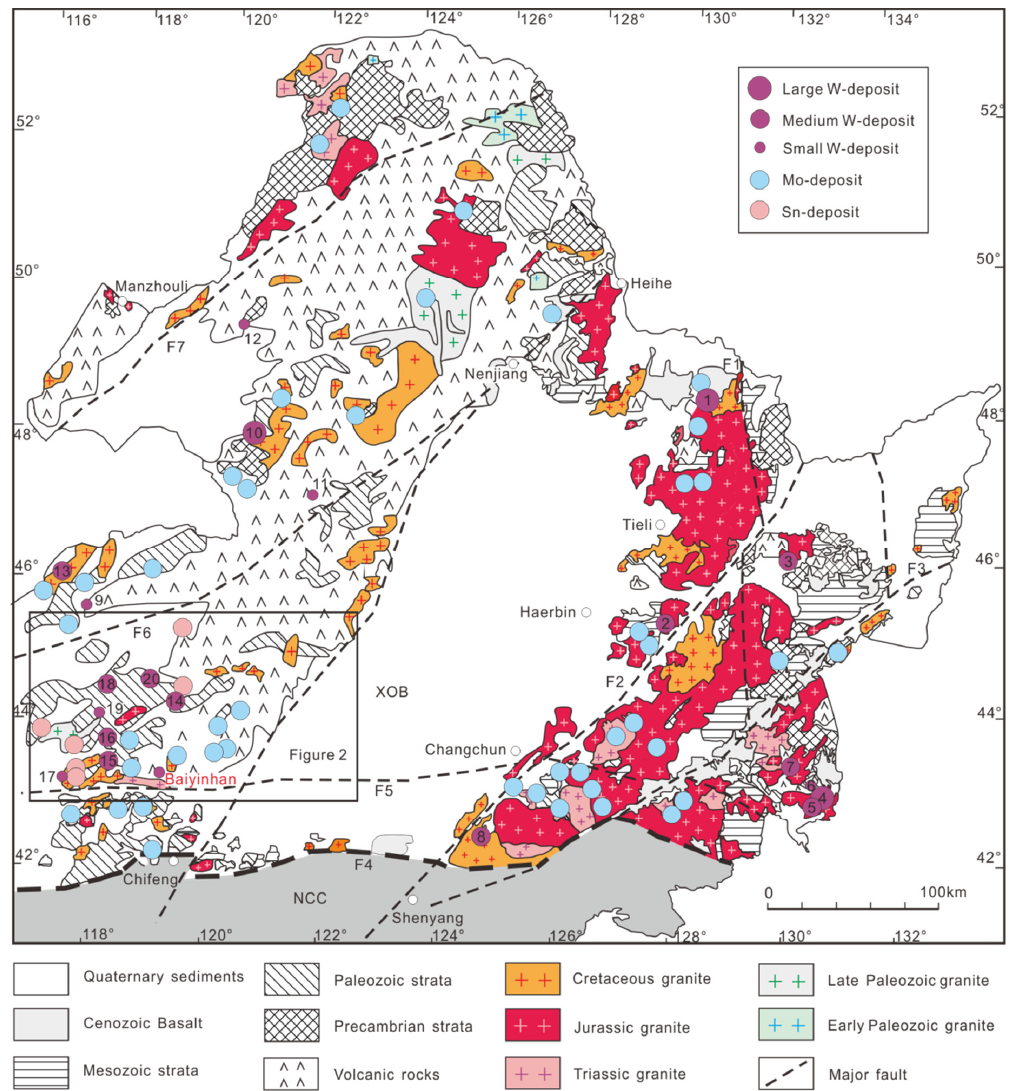
Figure 1. Geological map of the eastern part of the Central Asian Orogenic Belt and distribution of tungsten deposits in NE China (modified from [3]). Fault: F1—Nengjiang Fault; F2—Yitong-Yilan